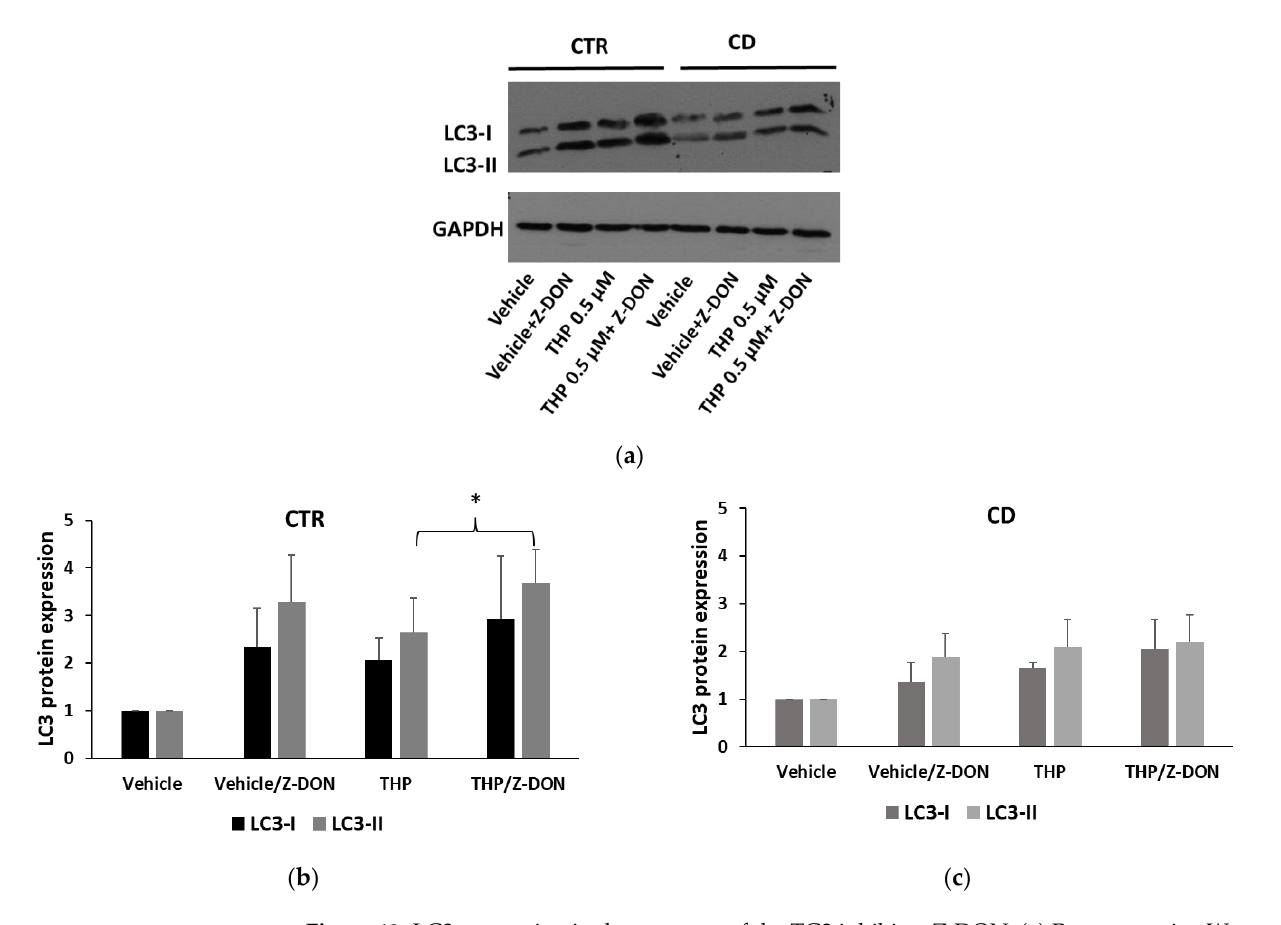
Figure 12. LC3 expression in the presence of the TG2 inhibitor Z-DON. ( a ) Representative Western blot anti-LC3 on samples from one control and one celiac culture in the presence of THP, Z-DON, and both for 24 h. ( b , c ) Densitometric analyses relative to Western blot anti-LC3 on samples from three control and three celiac cultures, respectively, in the presence of THP, Z-DON, and both. Protein levels of LC3 I and LC3-II are normalized with respect to GAPDH expression. Data are reported as mean ± SE. * p < 0.05 as indicated (Student’s t- test for unpaired data).